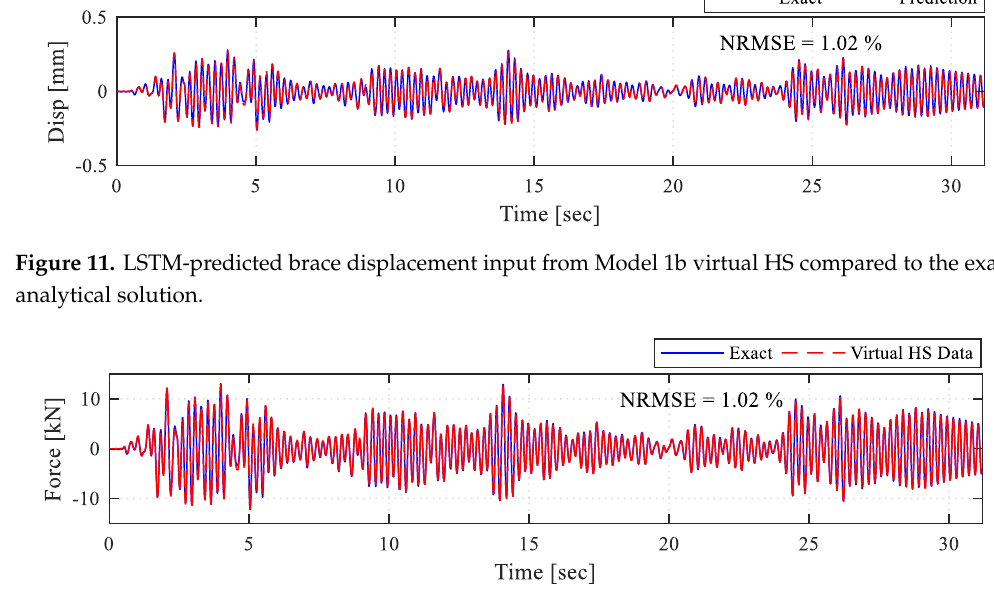
Figure 12. Brace force calculated from Model 1b virtual HS compared to the exact analytical solution.